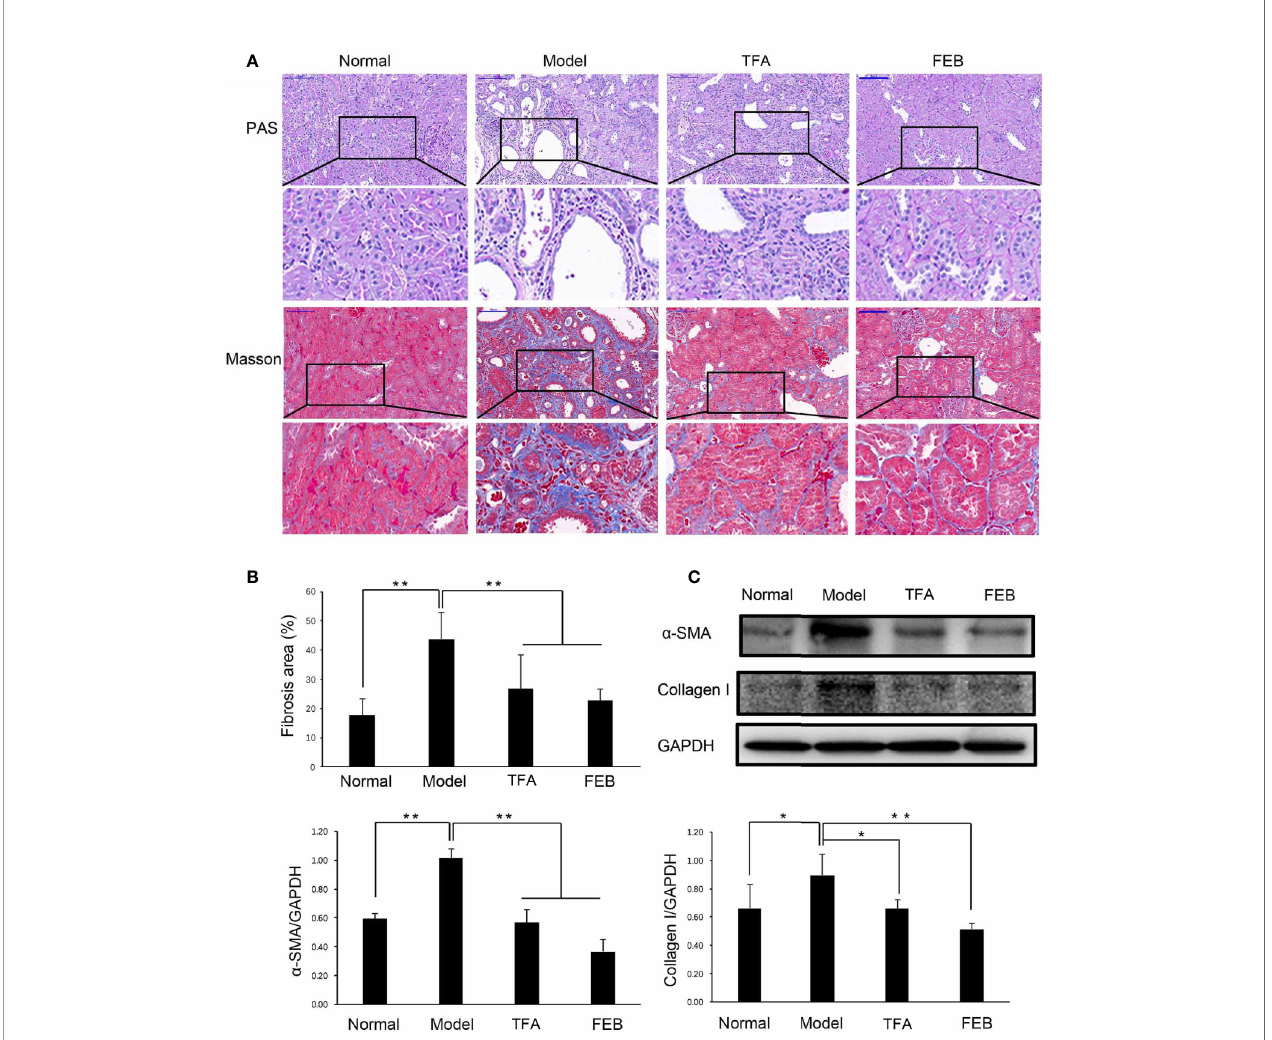
FIGURE 1 | Effects of TFA and FEB on renal injury. (A) Photomicrographs of periodic acid-Schiff (PAS) staining and Masson ’ s trichrome staining in the Normal, Model, TFA, and FEB rat groups. Scale bar: 100 m m. (B) Fibrosis area. (C) A WB analysis of a -SMA and collagen I in the kidneys of the Normal, Model, TFA, and FEB rats. The data are expressed as the mean ± SD, (n = 3). * P < 0.05, ** P < 0.01. TFA, total fl avones of Abelmoschus manihot ; FEB, febuxostat; a -SMA, a -smooth muscle actin; WB, Western blotting; SD, standard